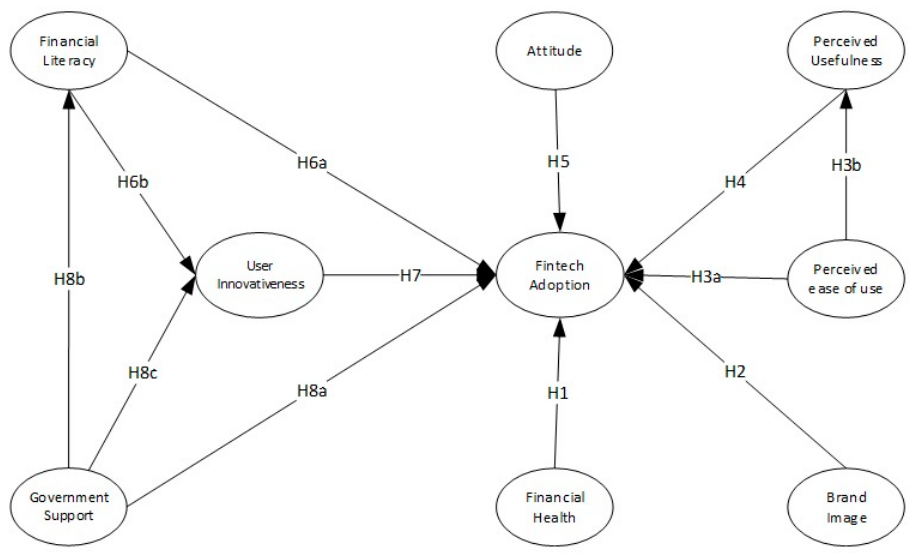
Figure 1. Research Framework.